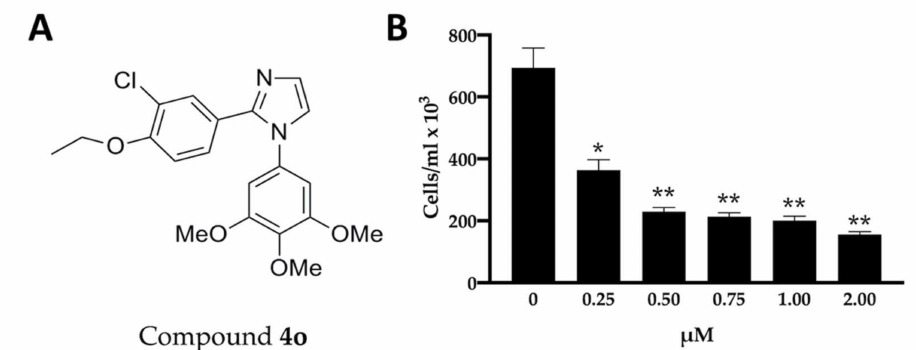
Figure 1. Structure of compound 4o and its effects on U251 cell proliferation. ( A ). Structure of compound 4o . ( B ). Effects of derivative 4o on U251 cell proliferation. U251 cells were cultured for 3 days in the absence or in the presence of the indicated concentrations of compound 4o . Results represent the cell number/mL values (mean ± SD; n = 3). p < 0.05 (*, significant), p < 0.01 (**; highly significant).